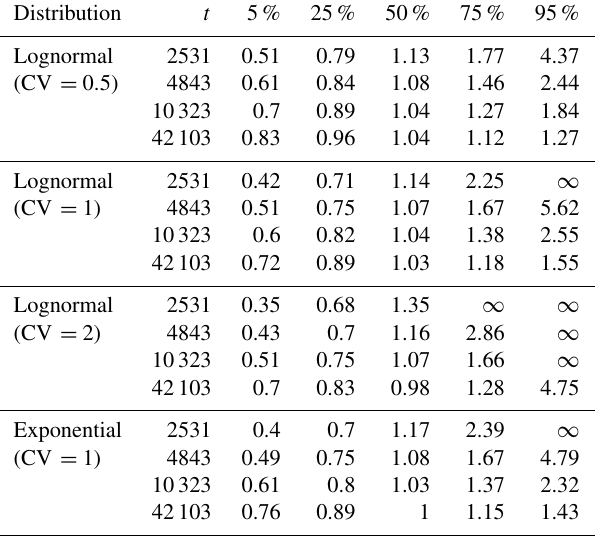
Table 1. Epistemic uncertainty table showing the percentiles for the slip rate variability (in mmyear − 1 ) at each time t (years). The long- term mean slip rate is 1mmyear − 1